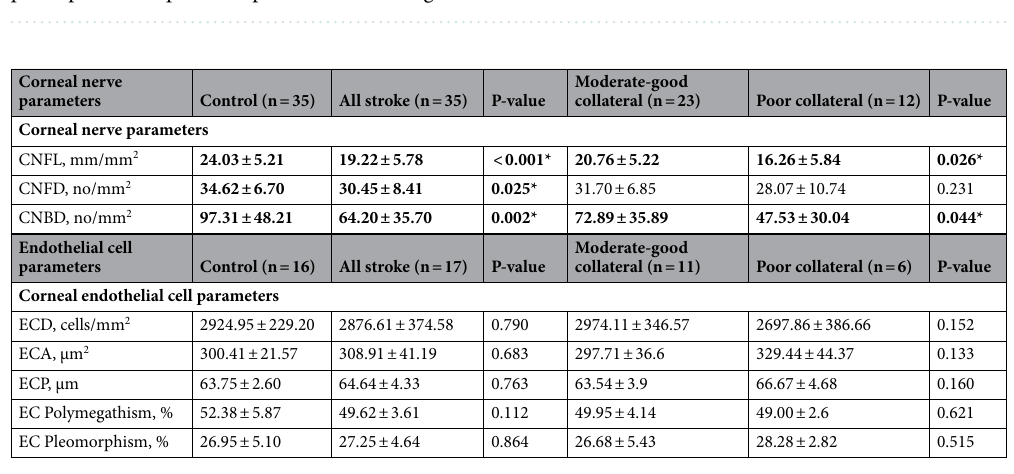
Table 2. Corneal nerve and endothelial cell measures comparing controls to patients with acute ischemic stroke and between patients with moderate-good and poor collaterals expressed as mean ± SD. *Statistically significant differences between groups tested using t-test at p < 0.05 (data in bold).